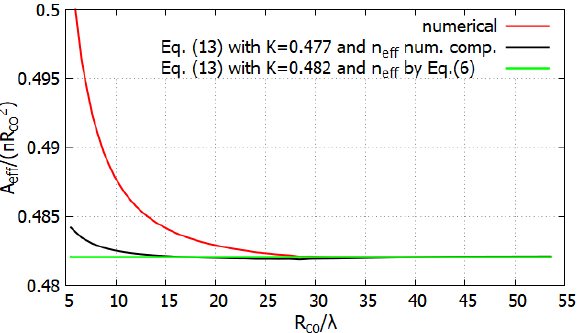
Figure 2. Effective area A ef f normalized to core area ( π R 2 co ) of a HF, plotted versus the core radius to wavelength ratio R co / λ : numerical computation (solid red curve), calculation by Equation (14) with n ef f numerically computed (solid black curve), and calculation by Equation (14) with n ef f given by Equation (7) (solid green